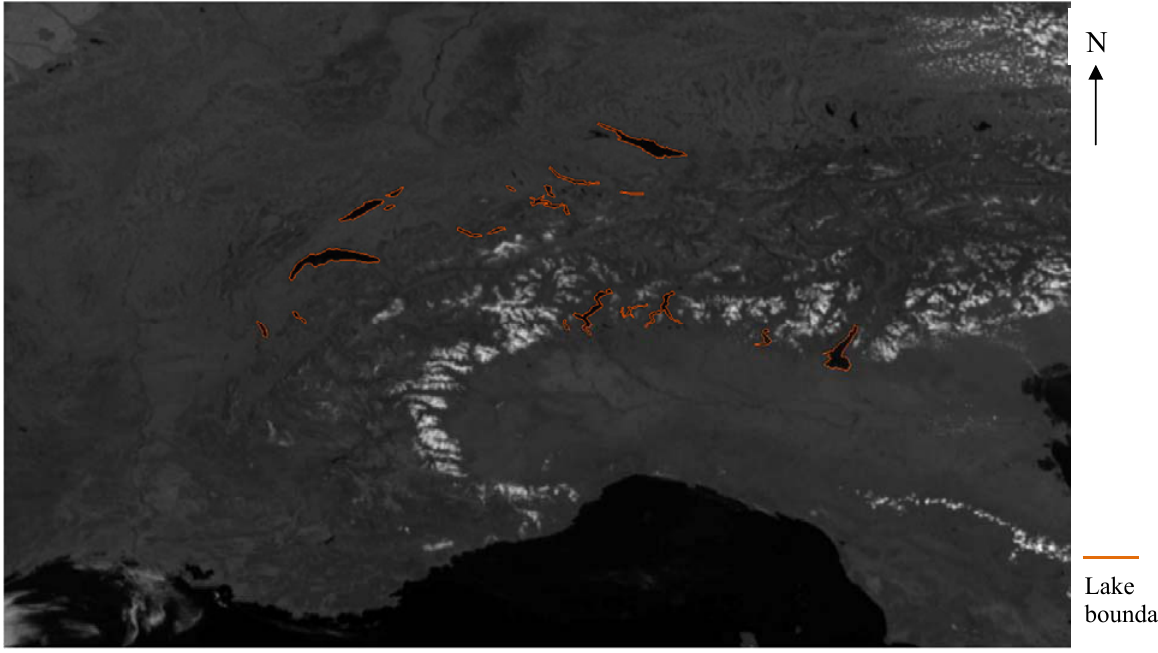
Figure 2. SEVIRI high resolution visible (HRV) image from 30.08.2008 and the lakes used for absolute accuracy